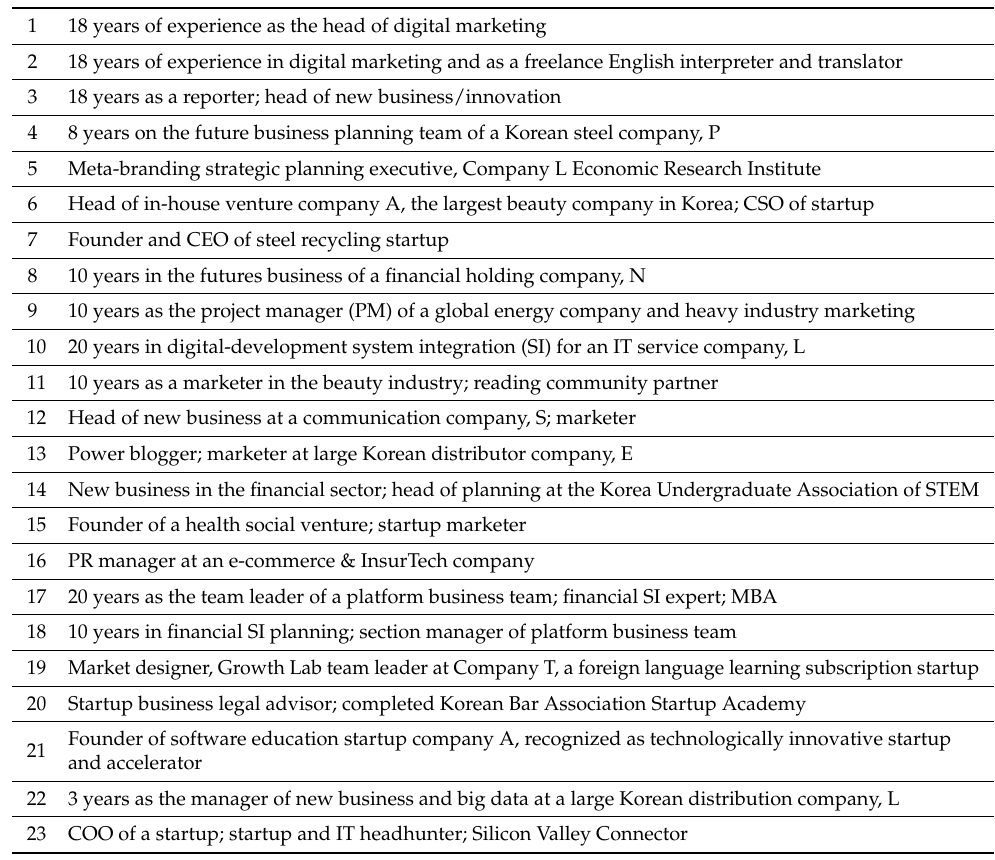
Table 4. Subjects of the one-group pretest–posttest design (31